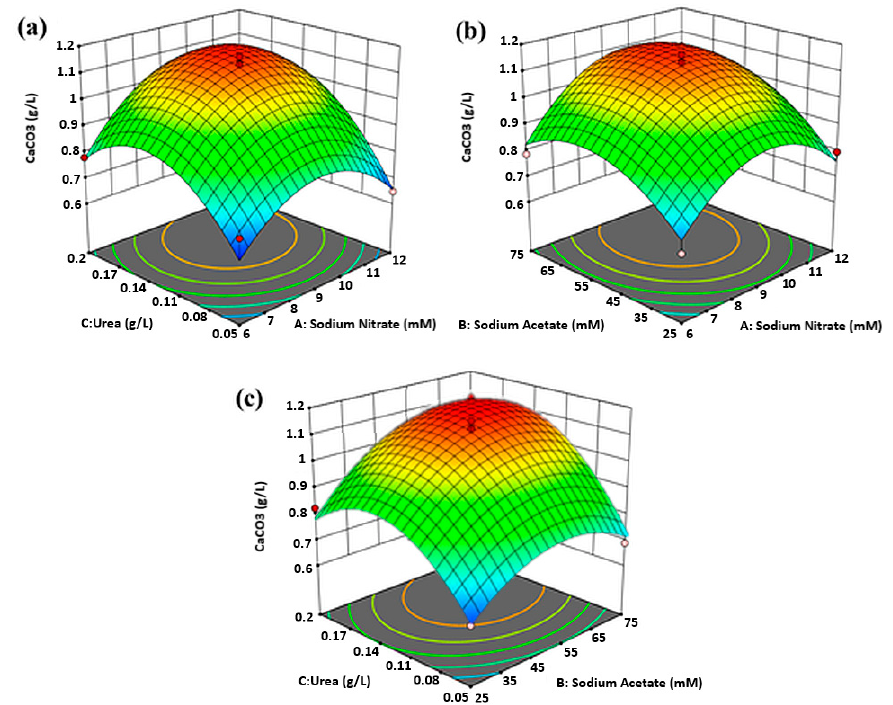
Figure 4. Response surfaces and contour plots showing the mutual effect of ( a ) urea and NaNO 3 , ( b ) sodium acetate and NaNO 3 , and ( c ) urea and sodium acetate on CaCO 3 precipitates concentration.